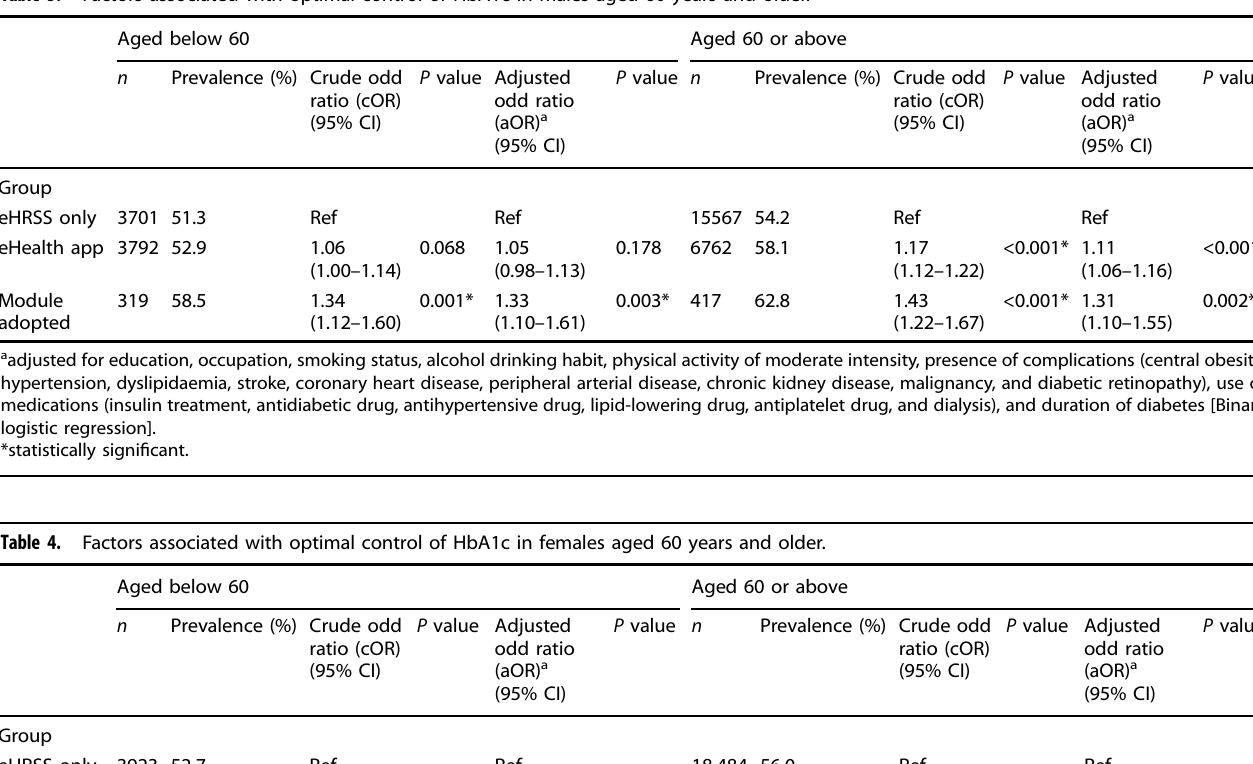
Table 3. Factors associated with optimal control of HbA1c in males aged 60 years and older.